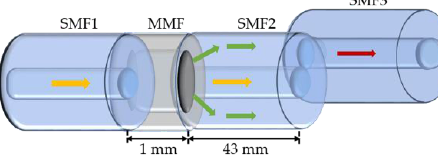
Figure 26. Schematic diagram of a magnetic field sensor based on an SMS fiber cascaded structure with core-offset fusion splicing between SMFs (adapted from [82]).